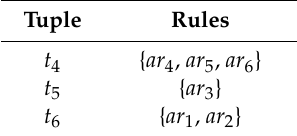
Table 14. Sets of di ff erent tuple_rules γ ( t ) with respect to sod 2